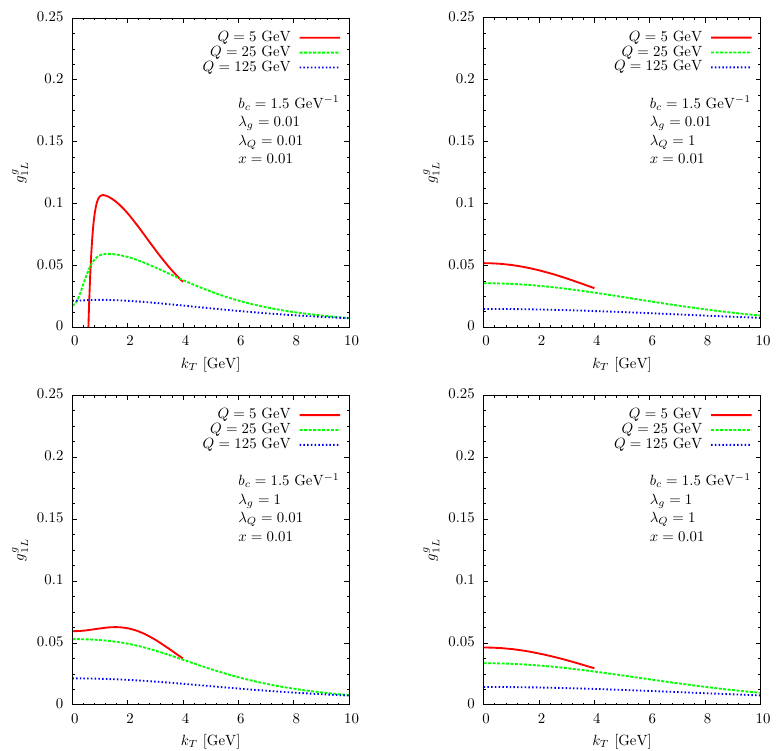
Figure 2 . The gluon helicity TMDPDF g g and the non-perturbative parameters, at